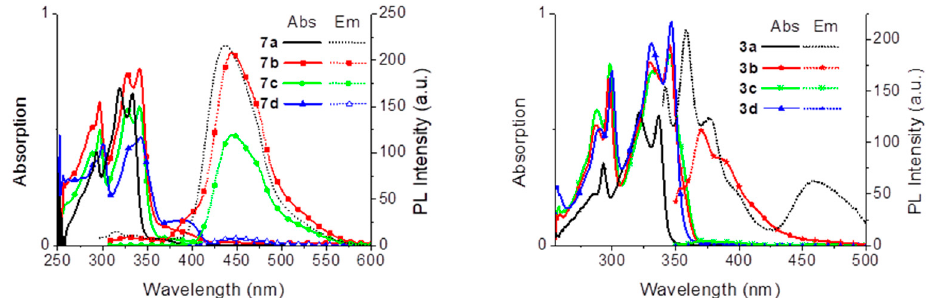
Figure 3. Absorption (full lines) and emission spectra (dotted lines) of compounds 7a – d and compounds 8a – d , in DMSO (at 1 × 10 − 5 mol L − 1 ). Table 1. Optical properties of compounds 7a – d and 8a – d .